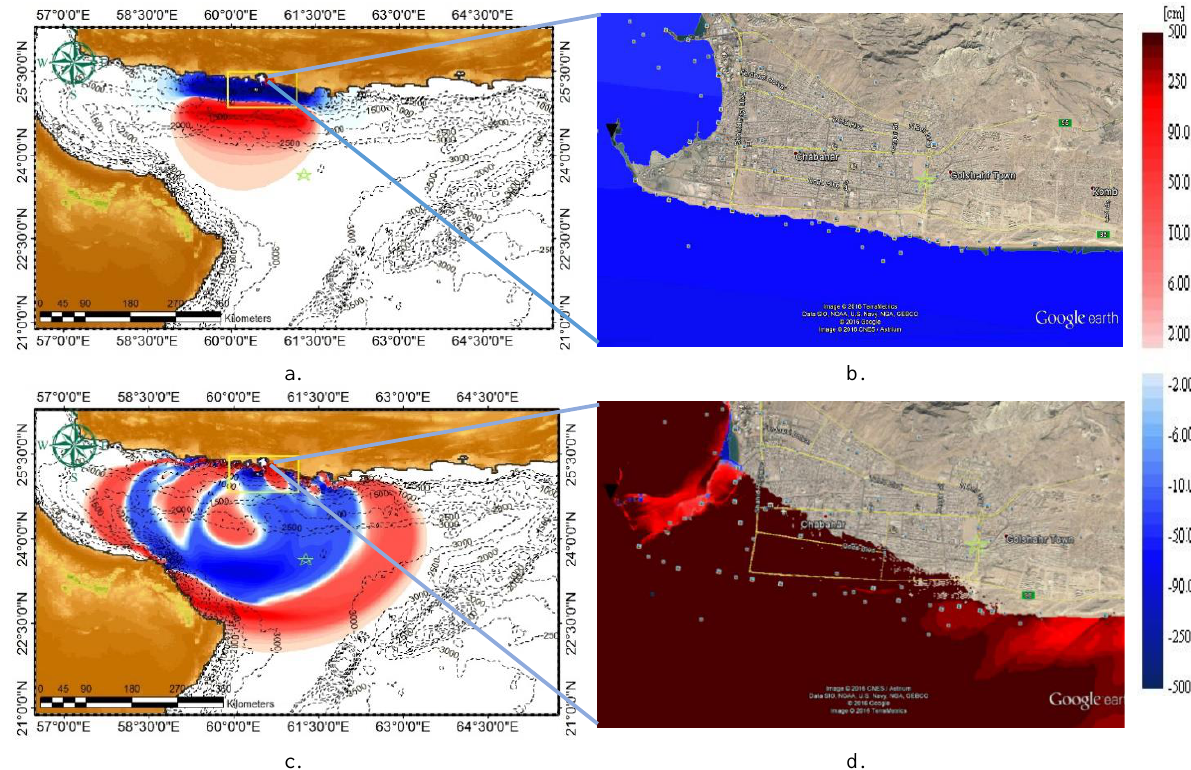
Figure 8. Snapshot of sea level deformation in Makran subduction zone affected the worst case tsunami at the generation time (a), deformation of coastal level in Chabahar port at the generation time (b), propagation of the tsunami wave and deformation of the sea level at 20 minutes after tsunami generation (c), inundation tsunami on Chabahar port at 20 minutes after generation